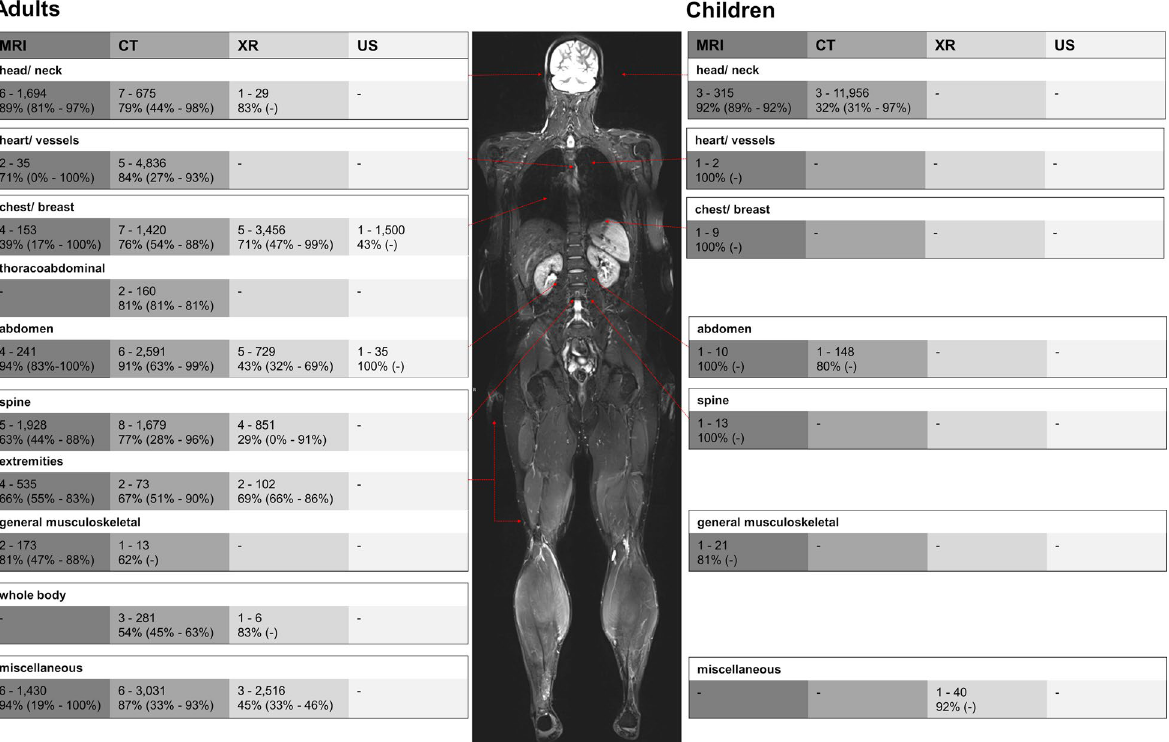
Fig. 3 Appropriateness of MRI, CT, X‑ray (XR) and ultrasound (US) in different body regions. The image shows the absolute number of studies and the accumulated number of reviewed examinations separated into different body regions. Based on the accumulated results, overall appropriateness (in %) was calculated presenting the span of study individual reported appropriateness in percent from lowest to highest. *Four studies reviewing the appropriateness of imaging other/miscellaneous body regions (CT MRI) [64], heart/vessels CT [86], chest/breast CT [65] + and whole body CT [89] reported the relative appropriateness without providing absolute numbers for different body regions. CT Computed tomography. MRI Magnet resonance imaging. XR Radiography. US